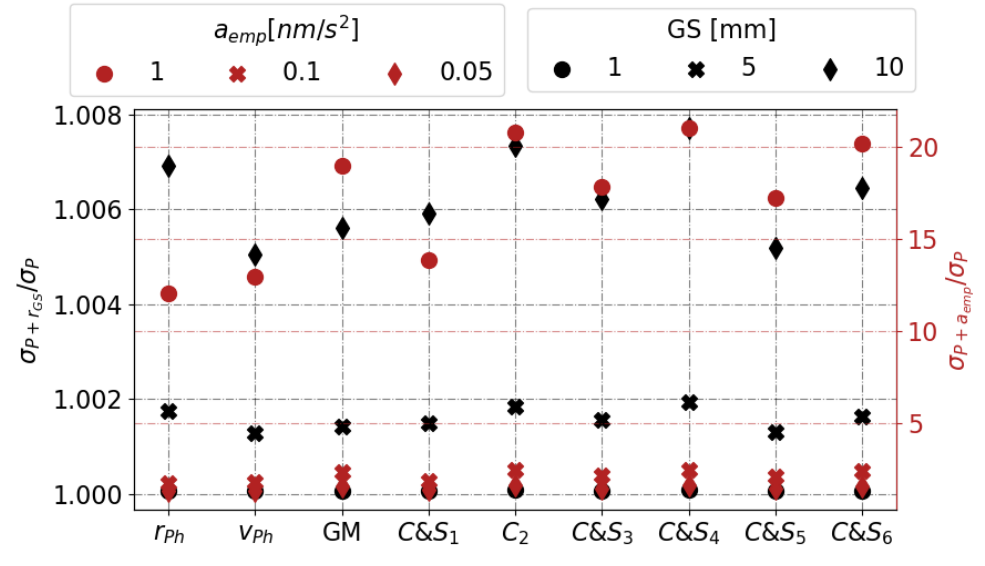
Figure 10. Formal error ratio: with(out) consider parameter influence, mean value across the